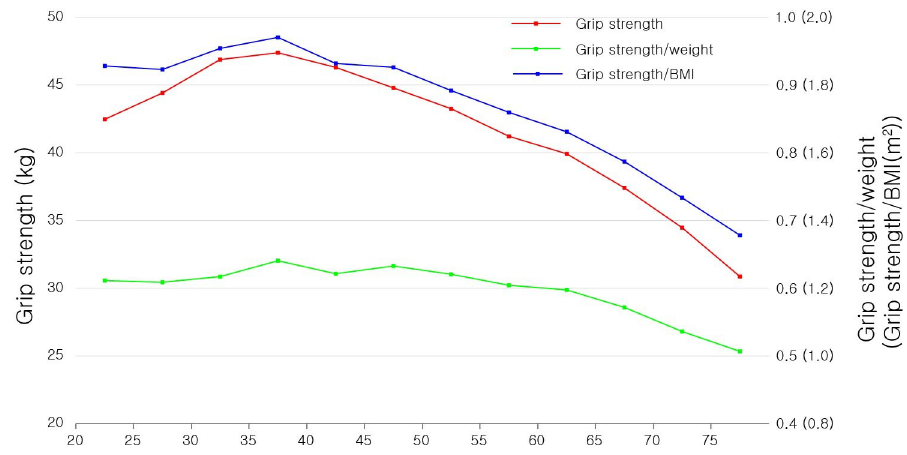
Fig 2. Grip strength, grip strength/body weight, and grip strength/BMI by age in men. BMI, body mass index.